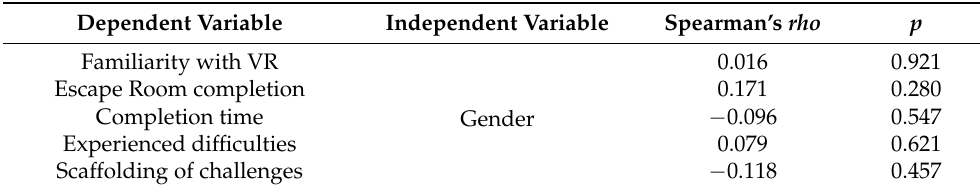
Table 5. Correlations between participants’ gender and the present experience. Dependent Variable Grouping Variable U Z p Perceived enjoyment 147 0.422 Motivation 150.5 Cognitive benefits 169.5 Gender Perceived learning 123.5 Satisfaction 123.5 − 1.460